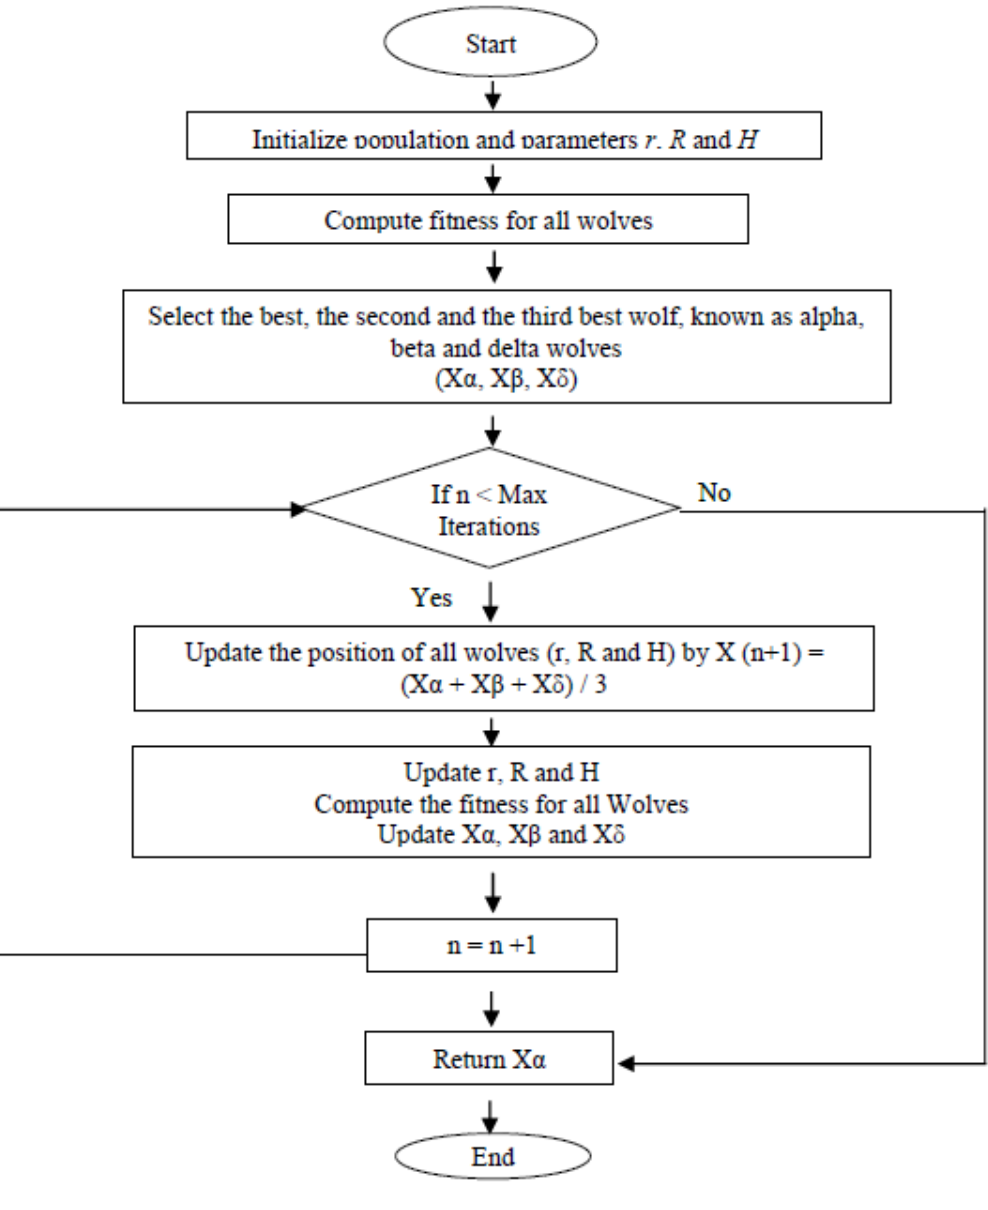
Figure 4. Flowchart of GWO.